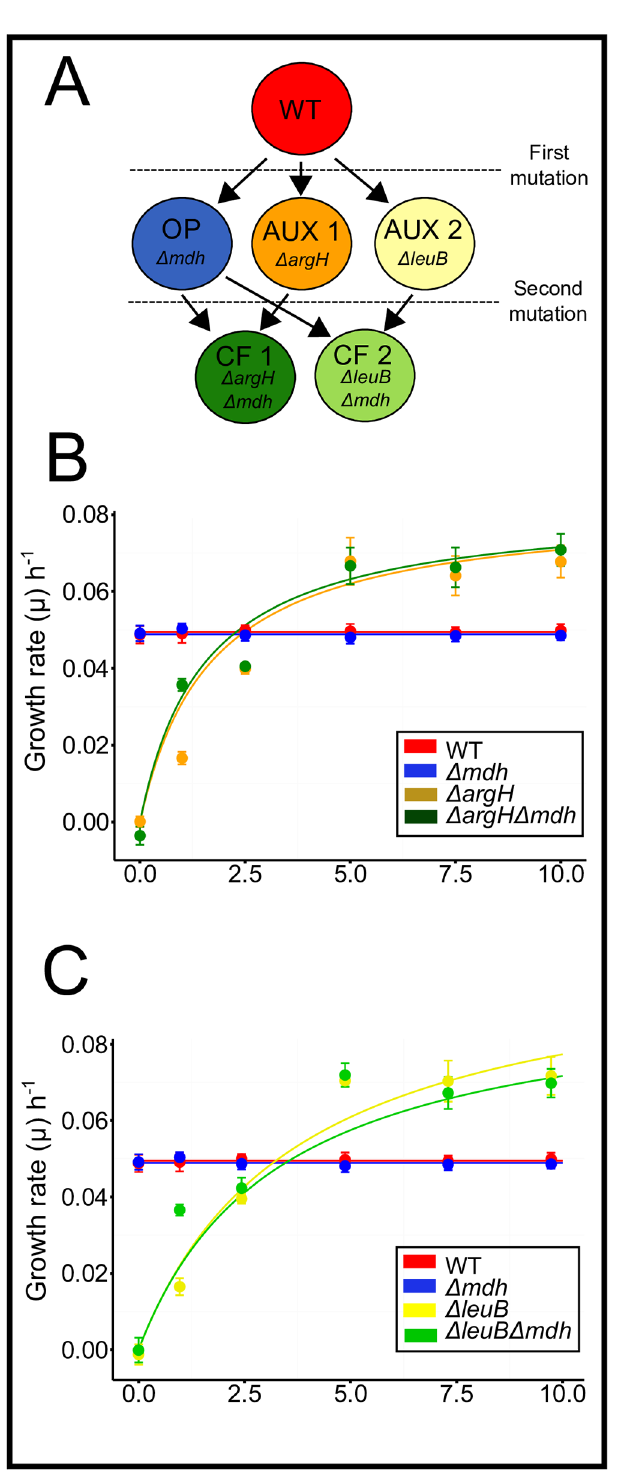
Fig 1. Schematic overview over the focal genotypes and their corresponding growth performance. (A) Genes deleted from the genome of the prototrophic wild type (WT) strain of Escherichia coli to yield mutants that are auxotrophic for the amino acids arginine or lysine (AUX1, AUX2), a mutant that overproduces a mixture of both amino acids (OP), and cross-feeding genotypes that are auxotrophic for one, yet produce increased amounts of the respective other amino acid (CF1, CF2). (B,C) Experimentally determined